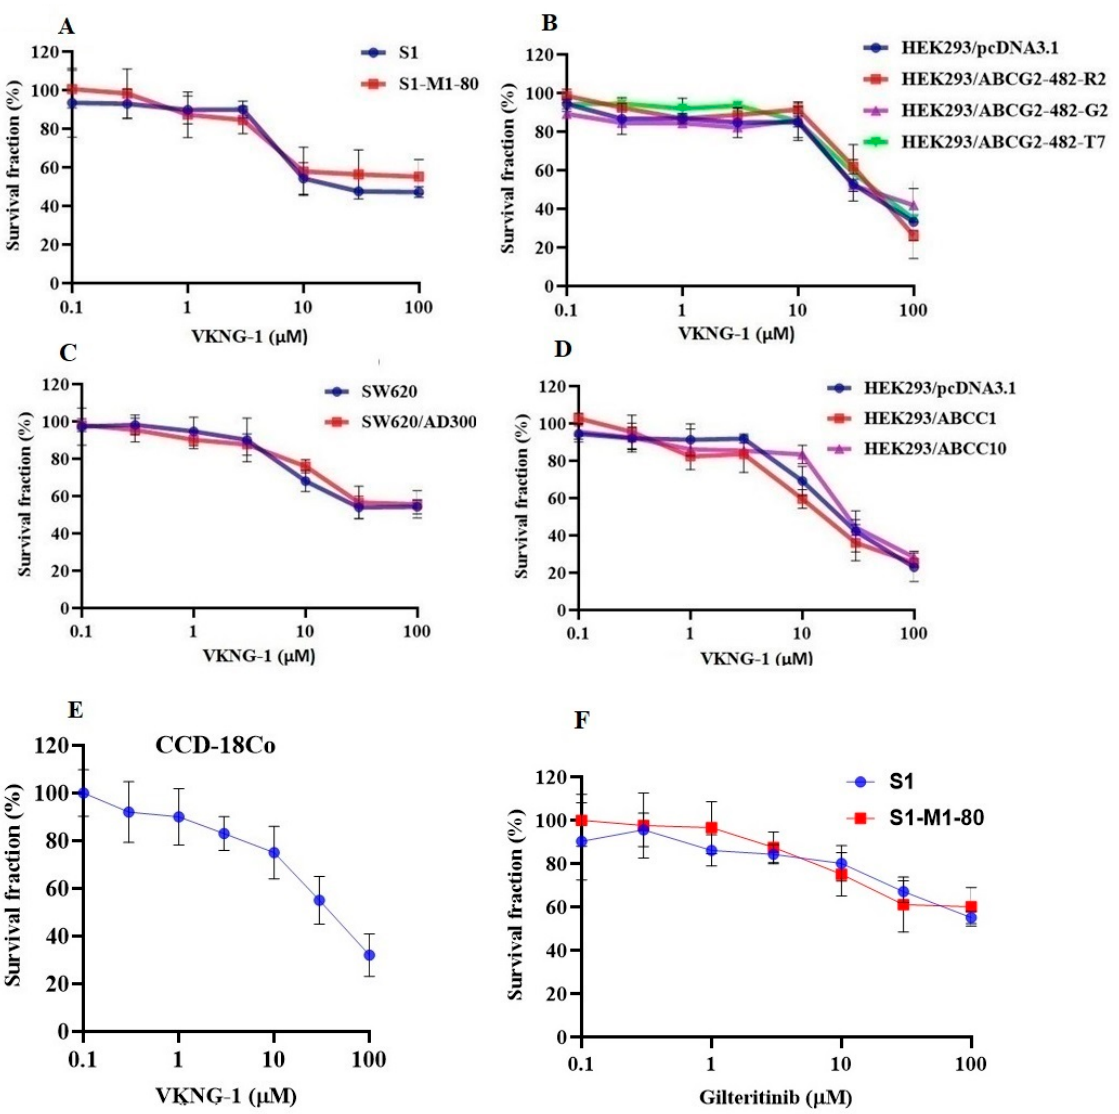
Figure 1. Cytotoxicity of VKNG-1 and gilteritinib on CCD-18Co, parental and drug-resistant cell lines. The S1 (blue) and S1-M1-80 (red) ( A ), HEK293/pcDNA3.1 (blue), HEK293/ABCG2-482-R2 (red), HEK293/ABCG2-482-G2 (violet) and HEK293/ABCG2-482-T7 (green) cell lines ( B ), SW620 (blue) and SW620/AD300 (red) cell lines ( C ) and HEK293/pcDNA3.1 (blue), HEK293/ABCC1 (red) and HEK293/ABCC10 (violet) cell lines ( D ) and CCD-18Co cell line ( E ) were treated with different concentrations of VKNG-1 (µM) for 72 h and S1 (blue) and S1-M1-80 (red) cells were incubated with gilteritinib (0-100 µM) for 72 h ( F ) and cell survival fraction (%) was measured. All data are shown as mean ± SD and represents three independent experiments.